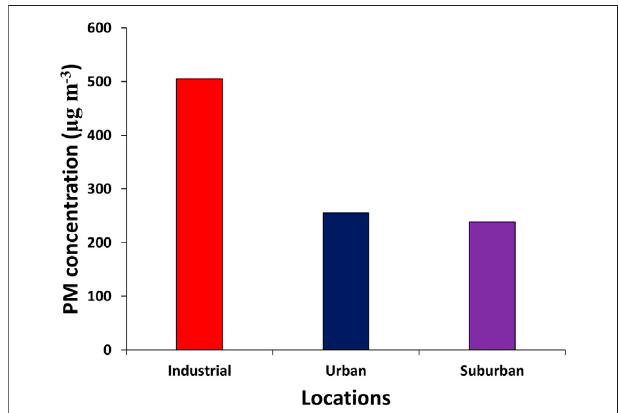
FIGURE 2 | Mean PM 10 concentration at three locations of Nowshera during the winter